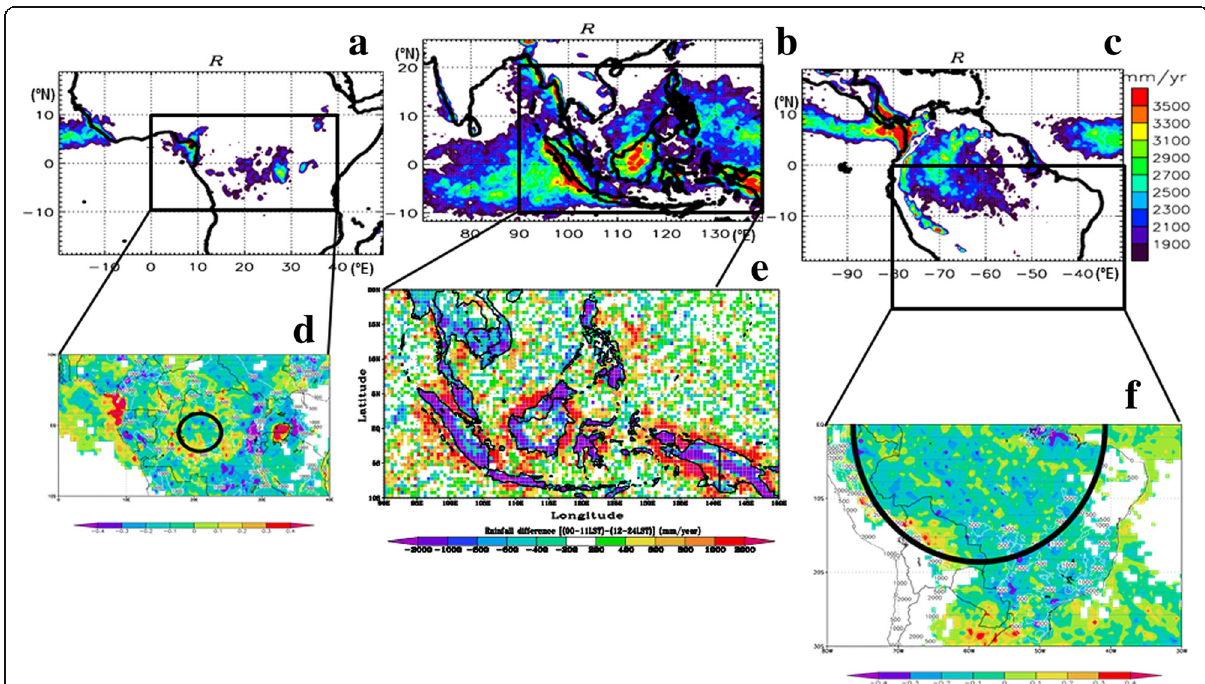
Fig. 8 a − c annual amount (analyzed for Dec 1997 − Jan 2011; Ogino et al. 2016) and d − f AM − PM difference (Jan 1998 − Dec 2000; Mori et al. 2004) of rainfall for a , d central Africa, b , e South/Southeast Asia, and c , f South America observed by the TRMM-PR. Circles in d , f indicate rough locations of the contour line around which the mountain valley breeze circulation